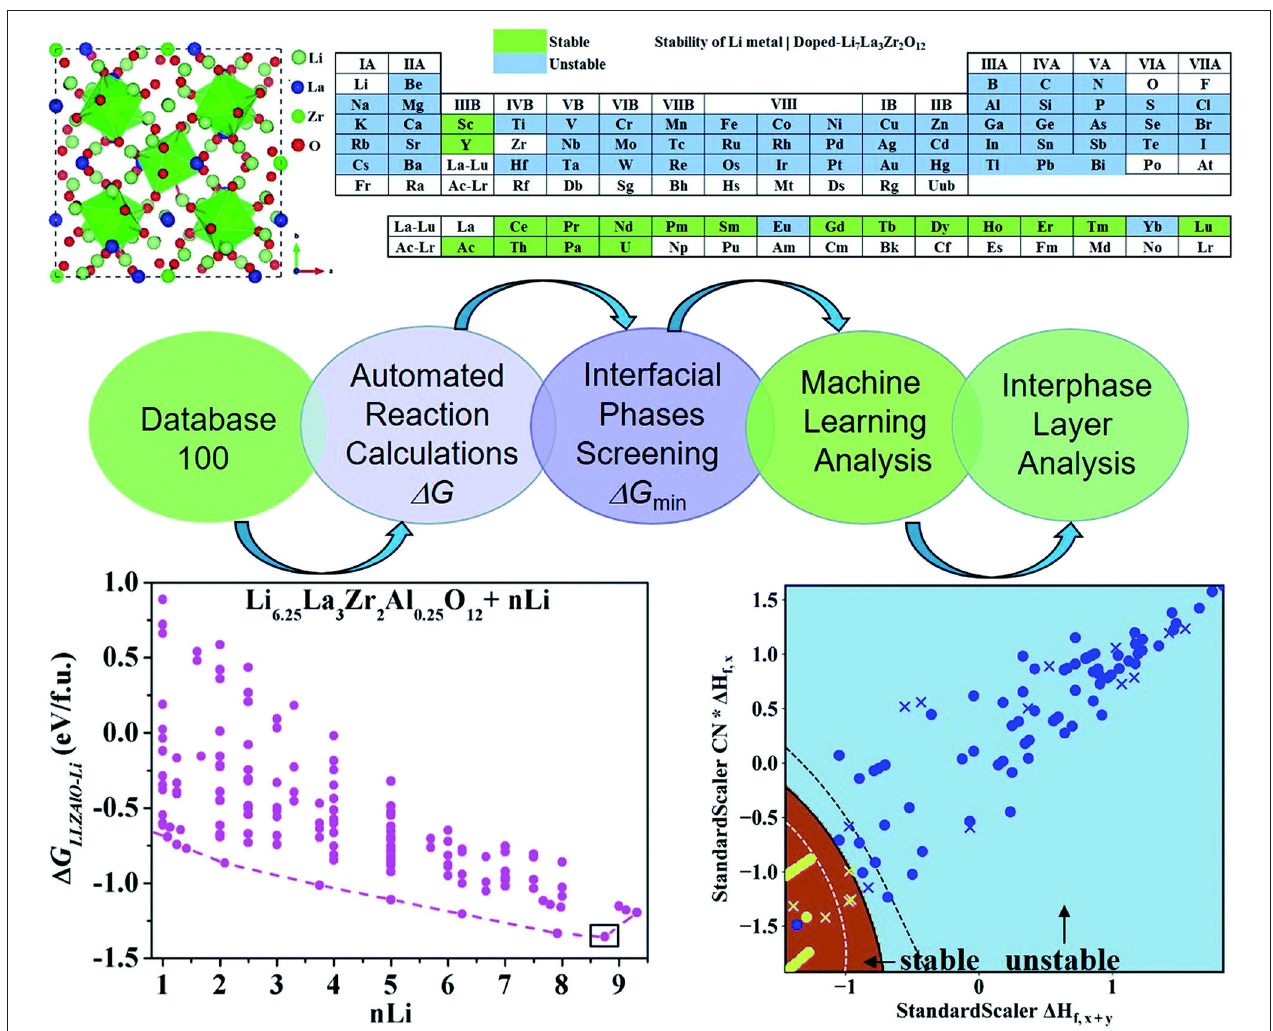
FIGURE 3 | ML and the automated interface reaction screening process workflow, which can expeditiously find cation-doped LLZO thermodynamically stable to lithium metal. The dopant screening, automated interface reaction screening, atomic structure, and interface stability ML classification results are presented. Reprinted with permission from Liu et al. (2019). Copyright (2013) Royal Society of Chemistry (Great